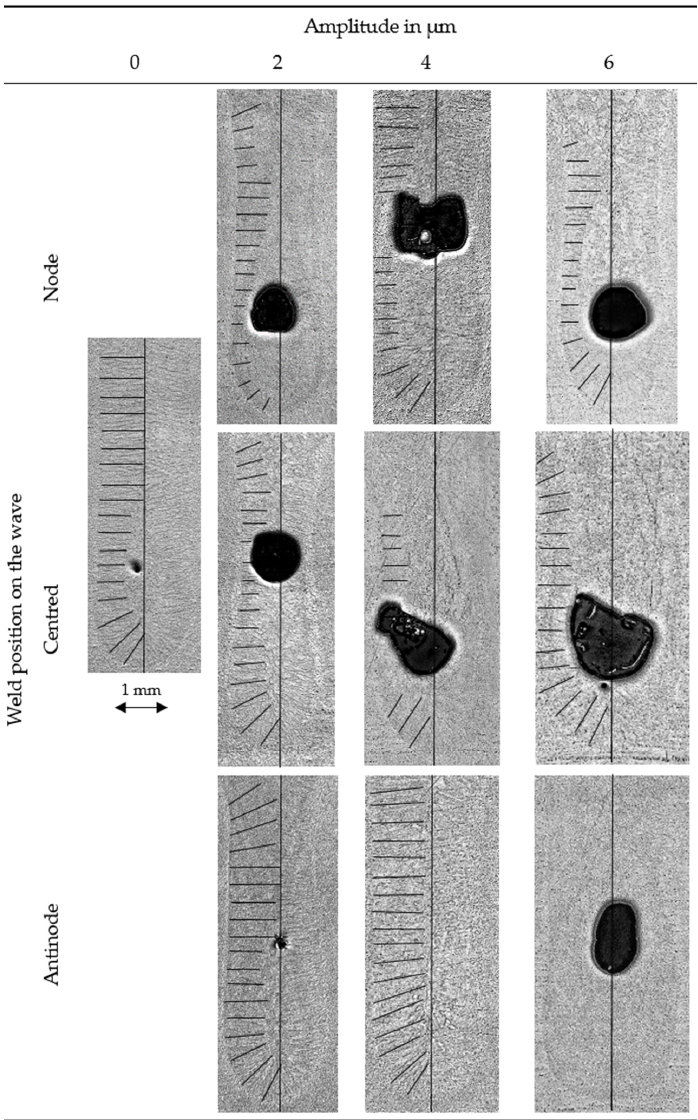
Figure 7. Exemplary micrographs of metallographic cross sections of welding seams (Material 2.4856), the columnar solidification is indicated by lines on one half of the weld with indicated columnar solidification areas, root area.